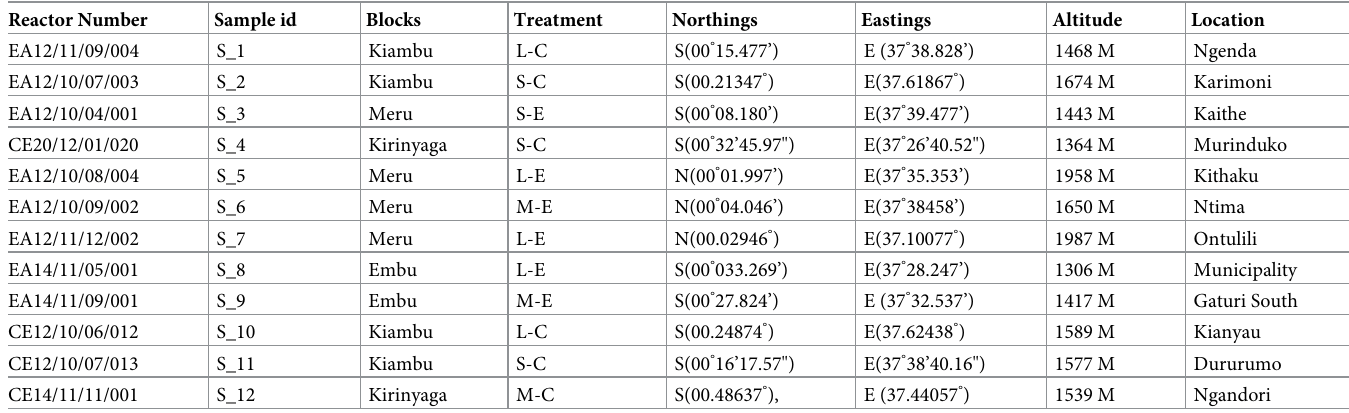
Table 2. The geographic positioning systems’ co-ordinate for the sampled reactor treatments, assigned to the four blocks of eastern and central regions of Kenya.